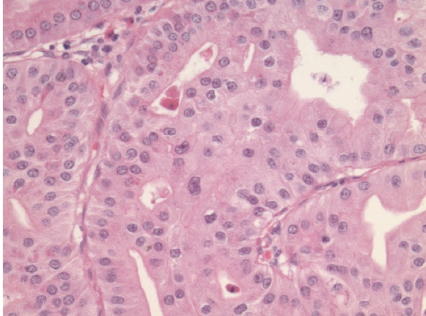
Figure 5: High power view exhibiting small amount of atypia of the PGA.